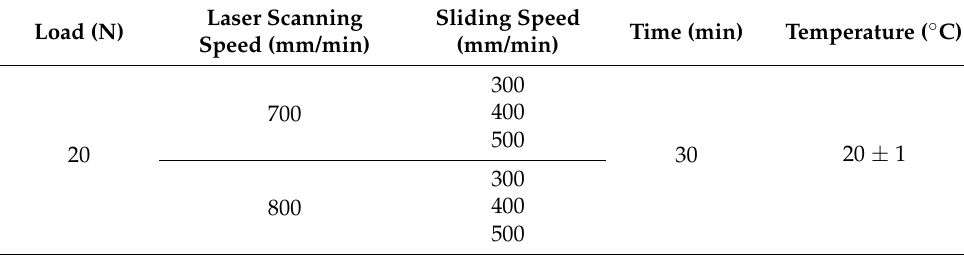
Table 3. Sliding speed effect